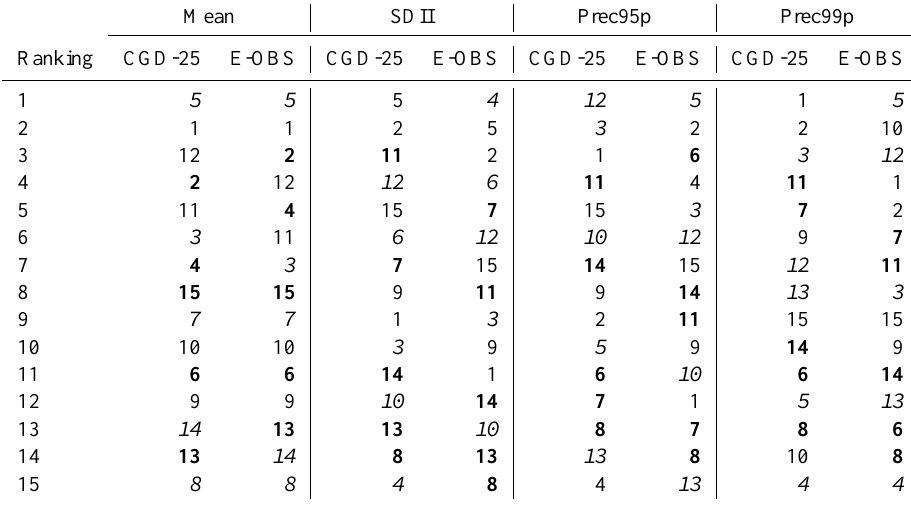
Table 3. Ranking of the RCMs depending on the RMSE of the semivariograms for the observational data sets. Model numbers are shown in Table 1. The models highlighted in roman, italic and bold correspond to the models with rank 1 to 5, 6 to 10 and 11 to 15 for SVK in Table 2,